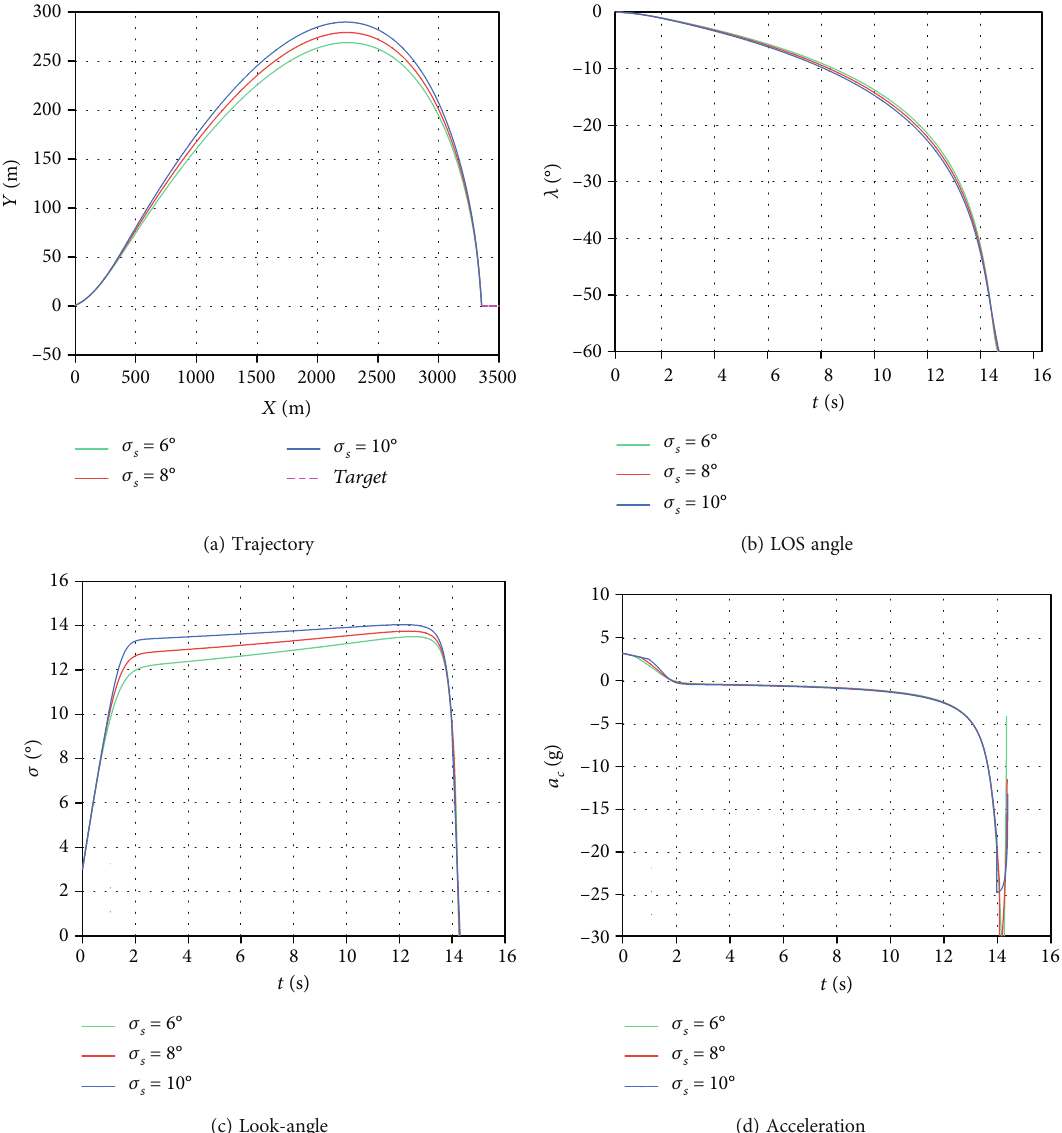
Figure 8: The results considering di ff erent switching